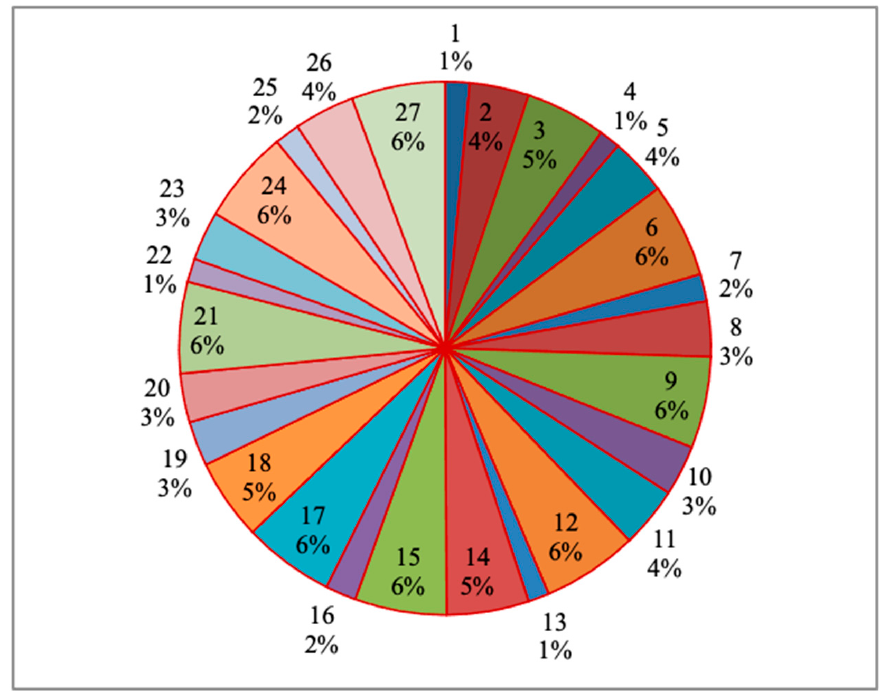
Figure 26. Process parameters influence on the surface roughness (µm) for each specimen.